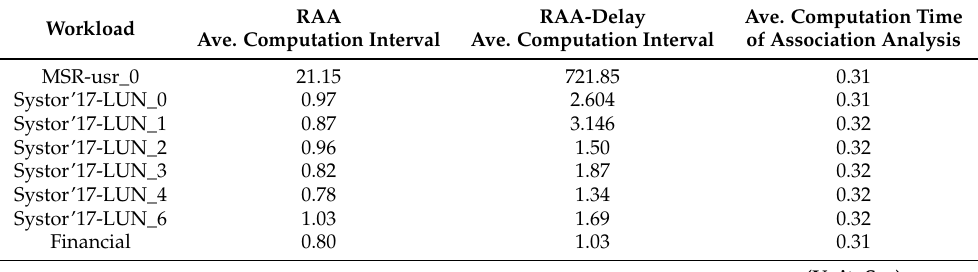
Table 4. Overhead